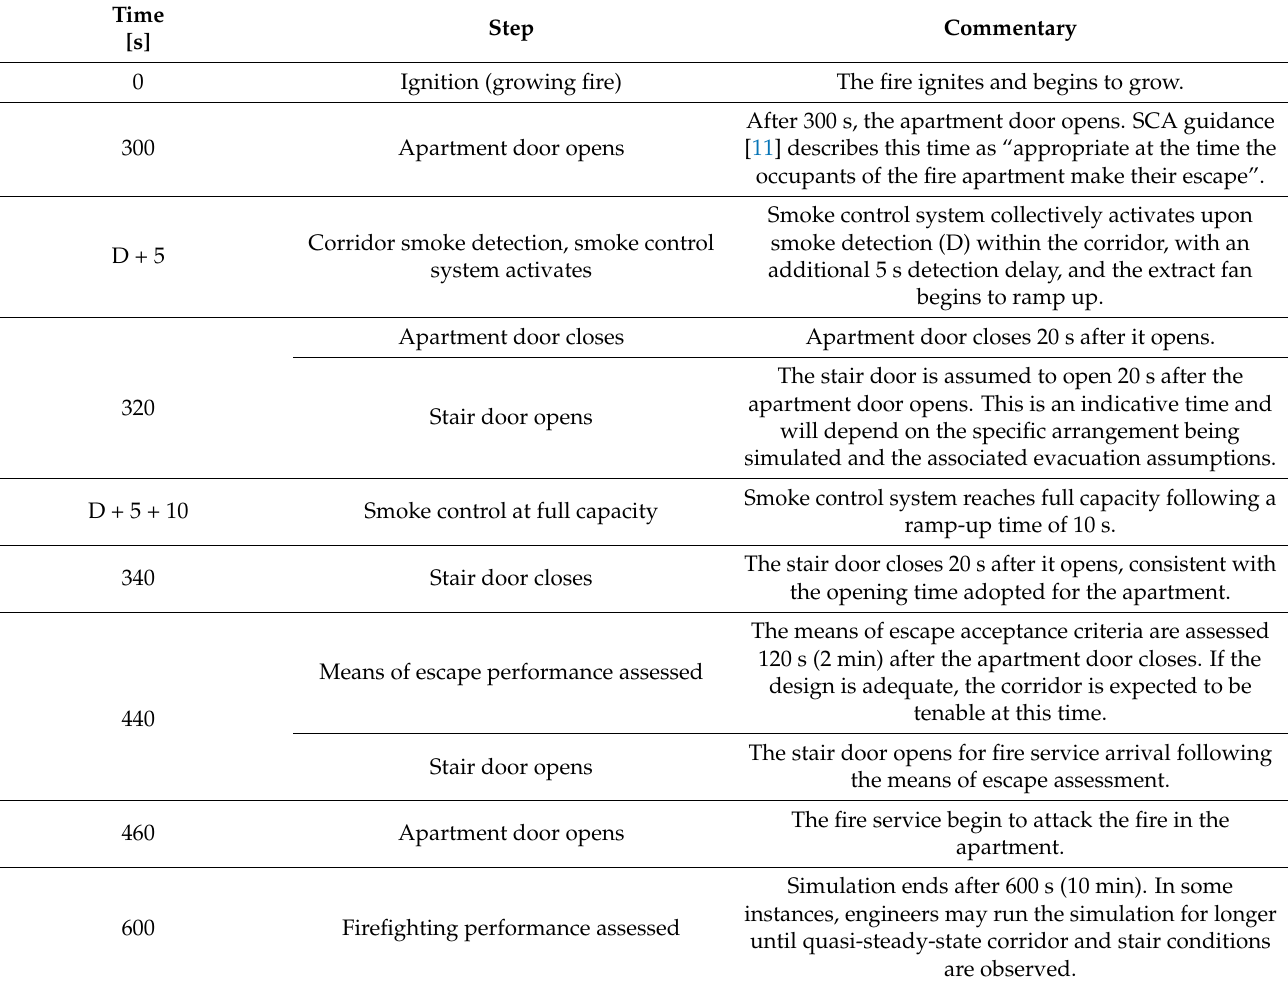
Table 3. Established timeline incorporating the means of escape and firefighting